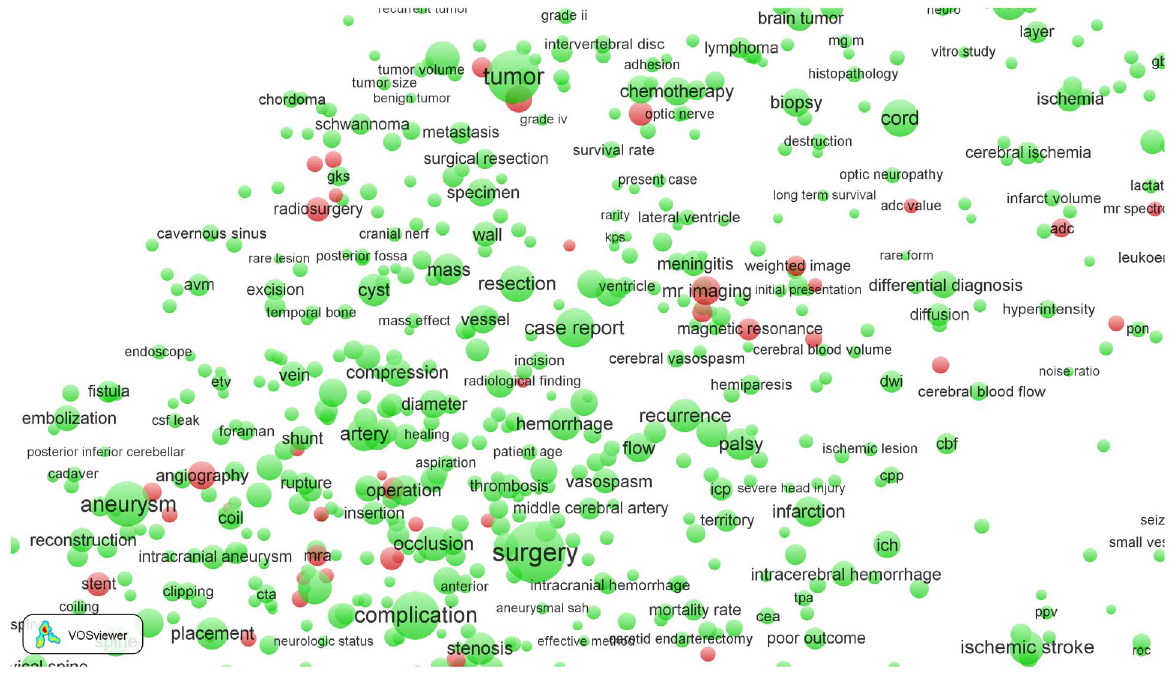
Figure 3. Term map of the Clinicalneurology field after zooming in into the clinical subfield.